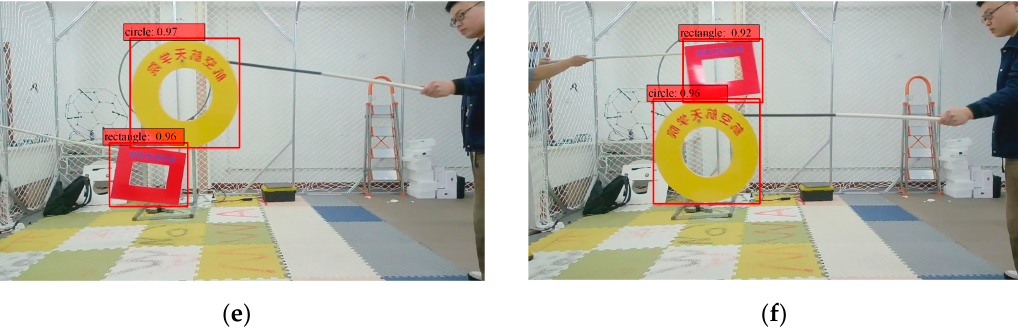
Figure 12. Example when using FDA-SSD for target detection: ( a , b ): Circular-target detection under different depth conditions; ( c , d ): rectangle-target detection under different depth conditions; and ( e , f ): classification of moving monochrome targets.